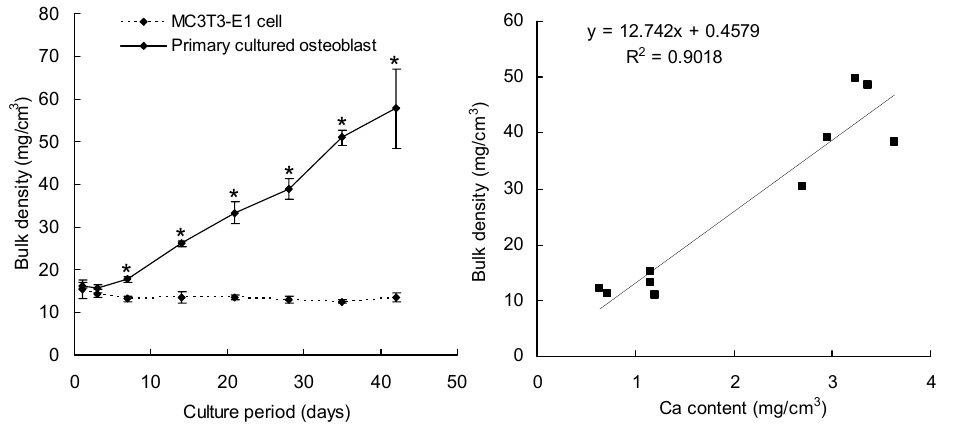
Fig. 7 Relationship between the bulk density of the tissue-engineered bone predicted by the optical system and calcium content measured by the colorimetric quantitative